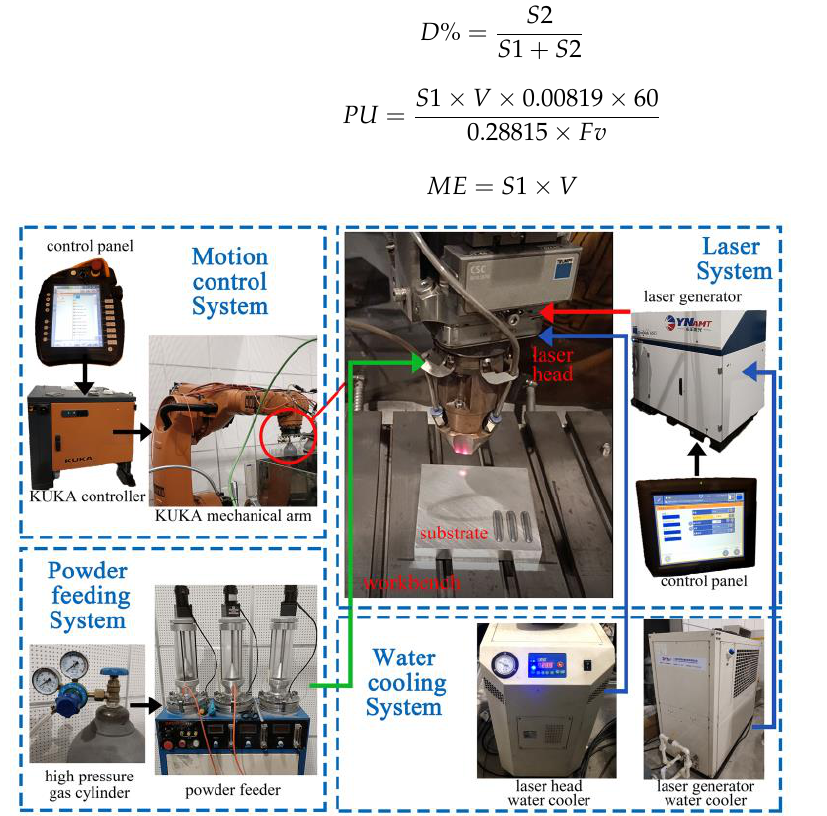
Figure 3. Laser cladding